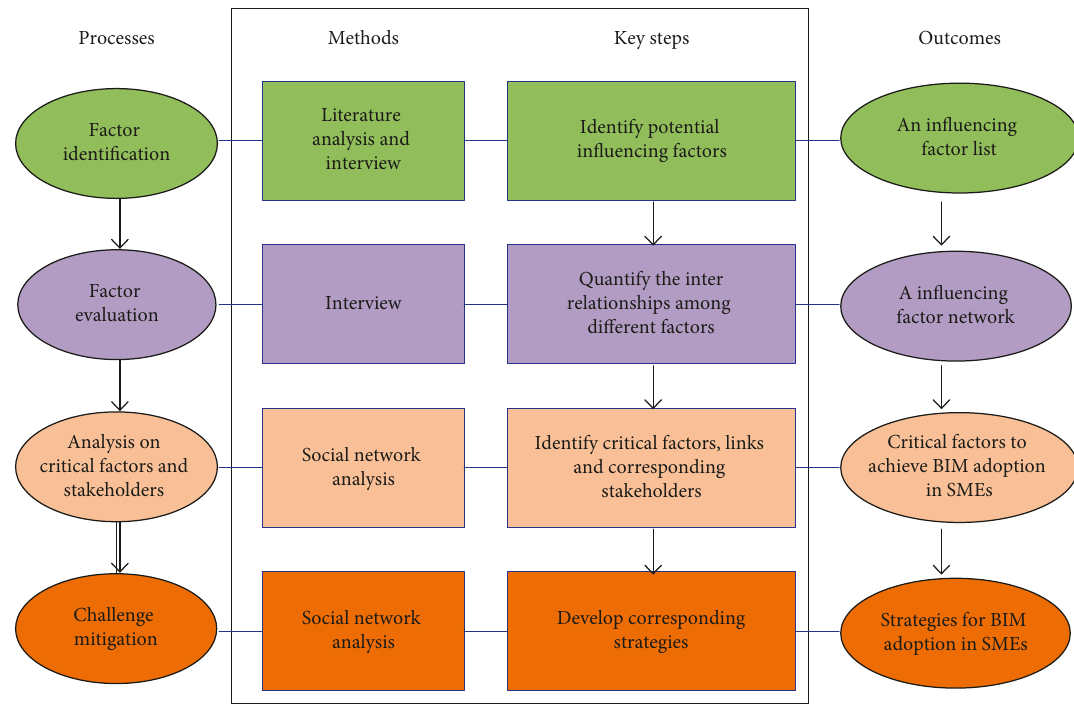
Figure 2: Research